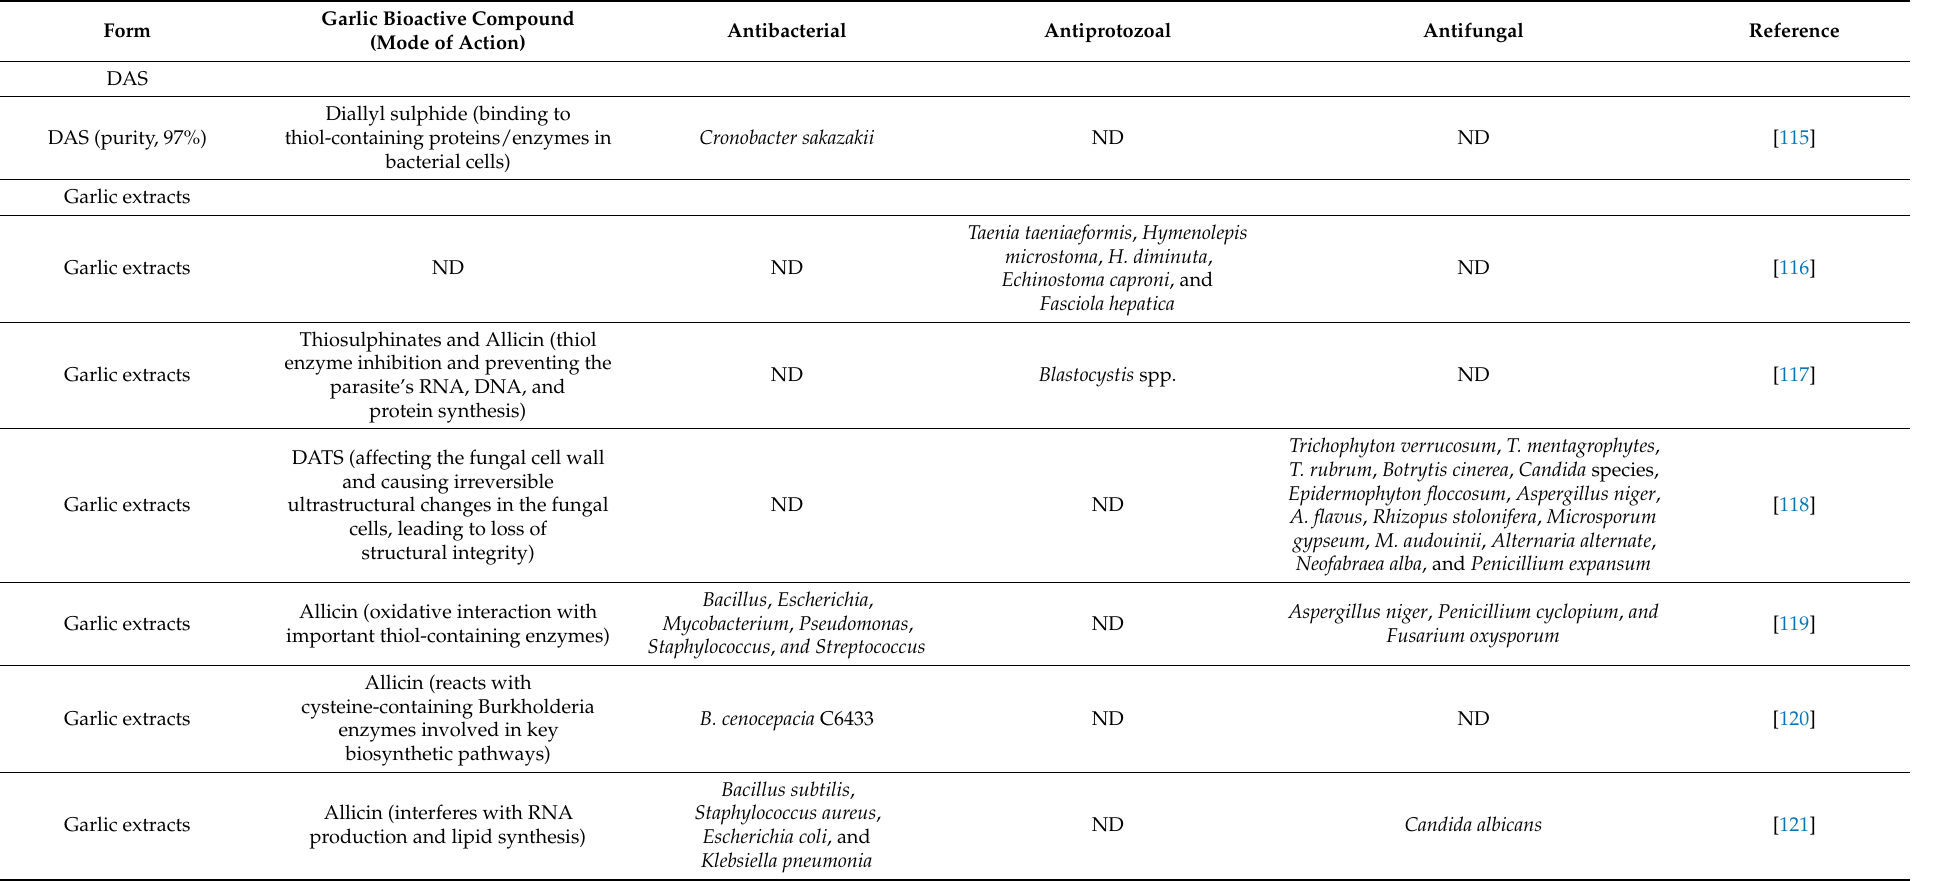
Table 1. Antifungal, antiprotozoal, antibacterial, antiviral of garlic and its